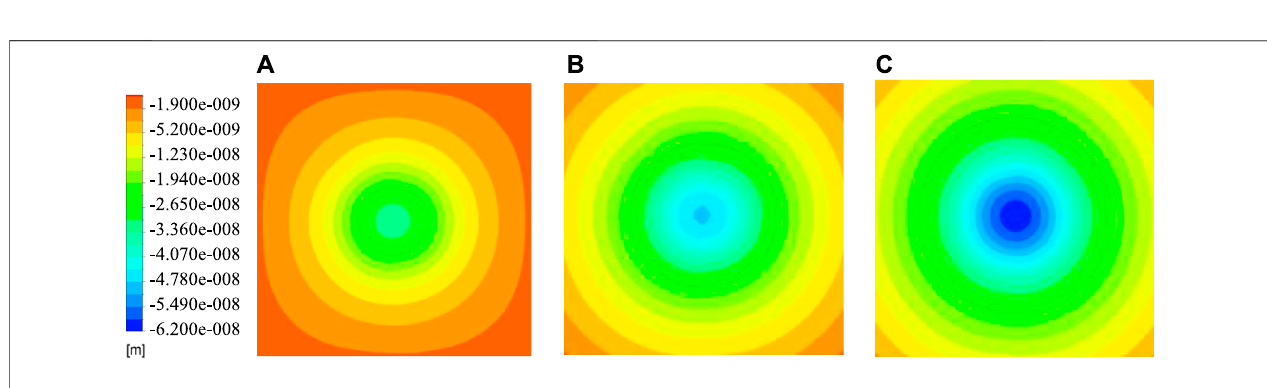
Frontiers in Physics |